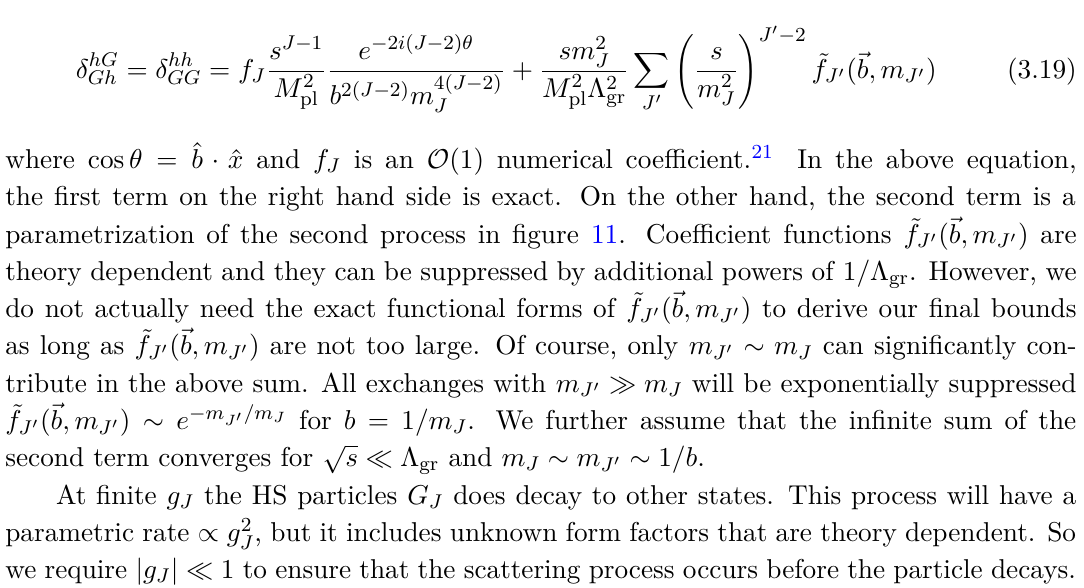
Figure 11 . In the eikonal limit the dominant contribution to δ hG exchange, as shown in (a). For large but finite Λ to δ hG and δ hh which is shown in (b). Note that the process with a graviton exchange is suppressed GG Gh by 1 /M 3 pl